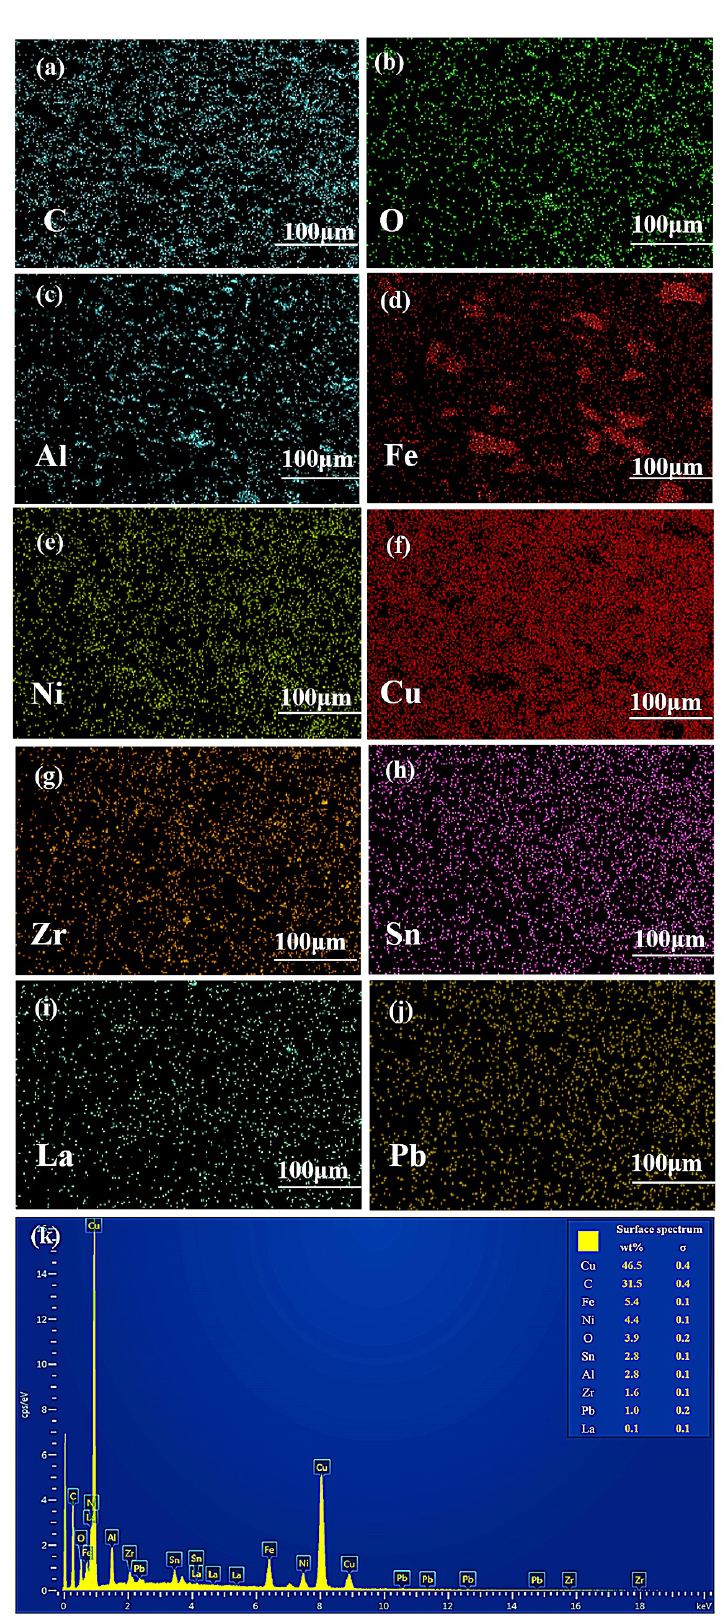
Figure 6. Corresponding EDS elemental mappings of sintered composites with 0.5 wt % alumina whiskers: ( a ) C; ( b ) O; ( c ) Al; ( d ) Fe; ( e ) Ni; ( f ) Cu; ( g ) Zr; ( h ) Sn; ( i ) La; ( j ) Pb; ( k ) surface